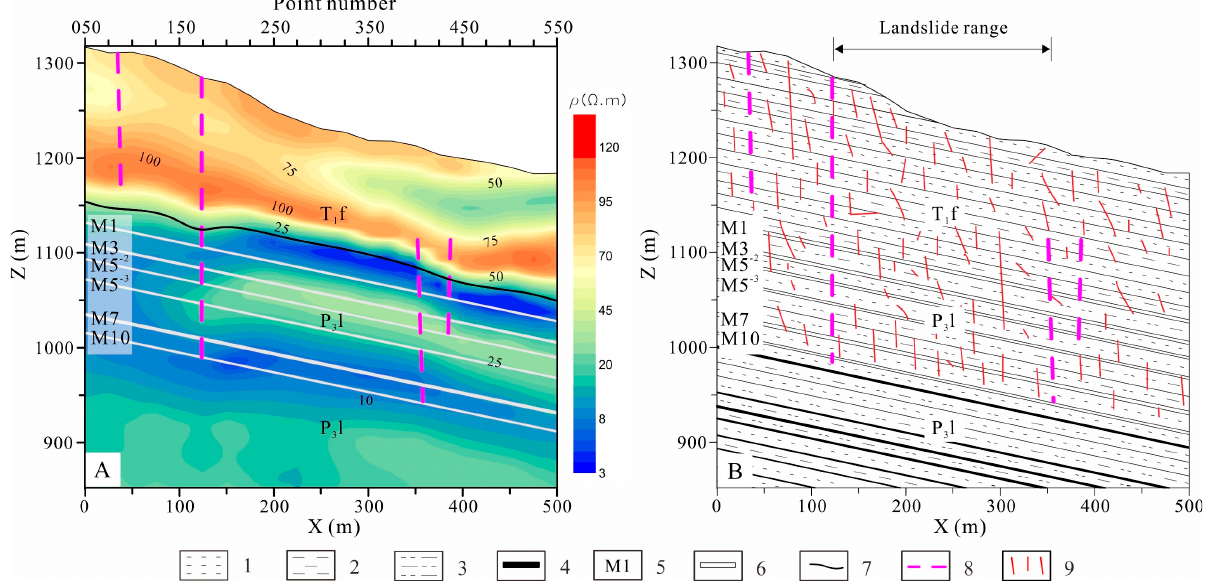
Figure 14. Surface transient electromagnetic inversion map of survey line II − II ′ : ( A ) section isoline of the apparent resistivity; and ( B ) geological section. (1. Sandstone; 2. Mudstone; 3. Argillaceous siltstone; 4. Coal seam; 5. Coal seam number; 6. Goaf; 7. Stratigraphic boundary; 8. Steep and deep fractures; 9. Fracture and subsidence zone).